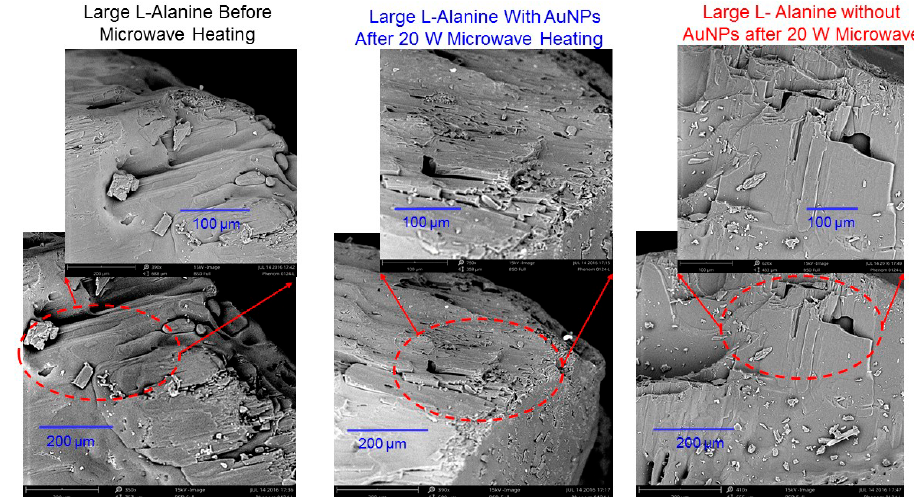
Figure 8. SEM images of large L -alanine crystals (4300 μ m) ( a ) before and ( b ) after microwave heating for 120 s in the presence of gold nanoparticles (i.e., the MAMAD technique) and ( c ) after microwave heating in the absence of gold nanoparticles (control) at 20 W. Scale bars are 200 μ m (large image) and 100 μ m (small image).